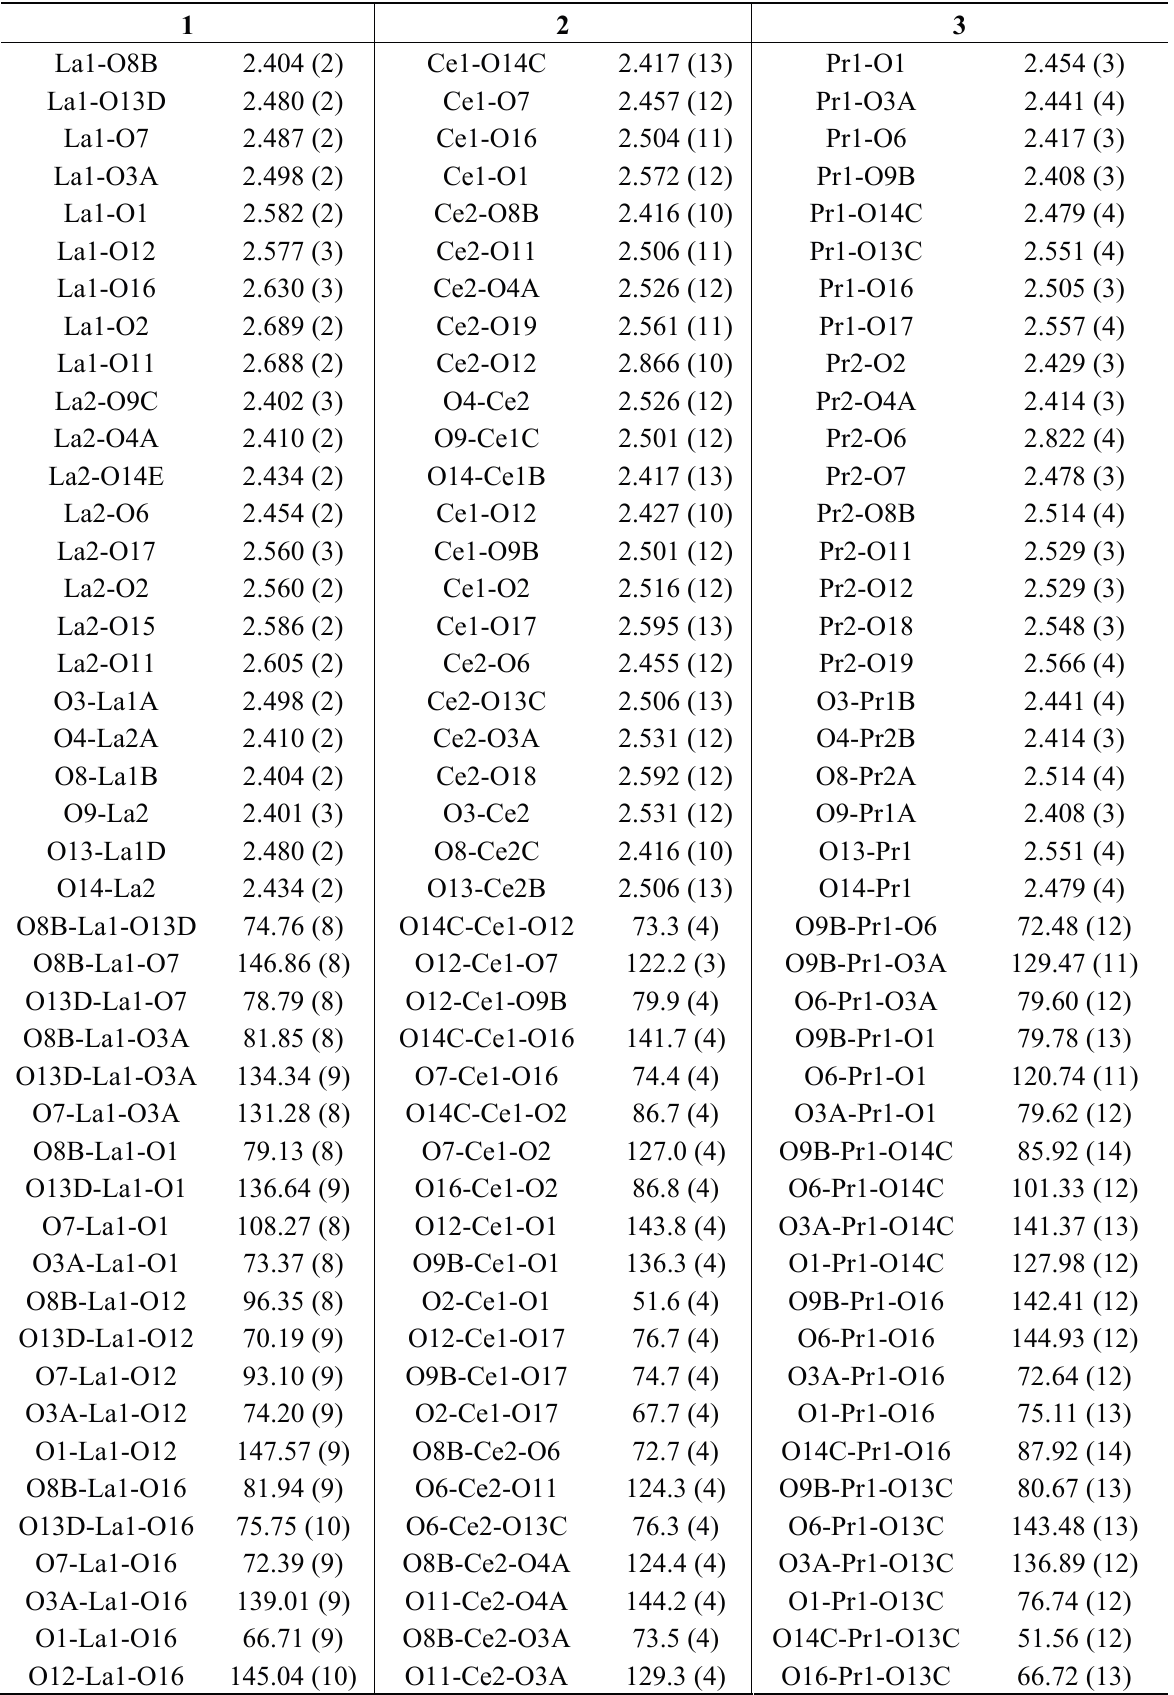
Table 2. Selected bond lengths (Å) and bond angles (°) for complexes 1 – 3